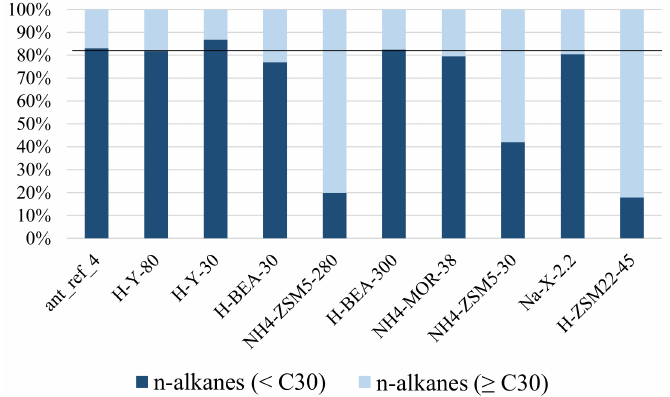
Figure 6. The relative quantities of n-alkanes smaller than n-triacontane (<n-C 30 ) versus n-alkanes equal to or larger than triacontane ( ≥ n-C 30 ) recovered from the n-hexane extracts of the zeolite samples exposed to M. pharaonis foragers. The distributions of the two groups in the reference sample (H-Y-80) are shown by the black